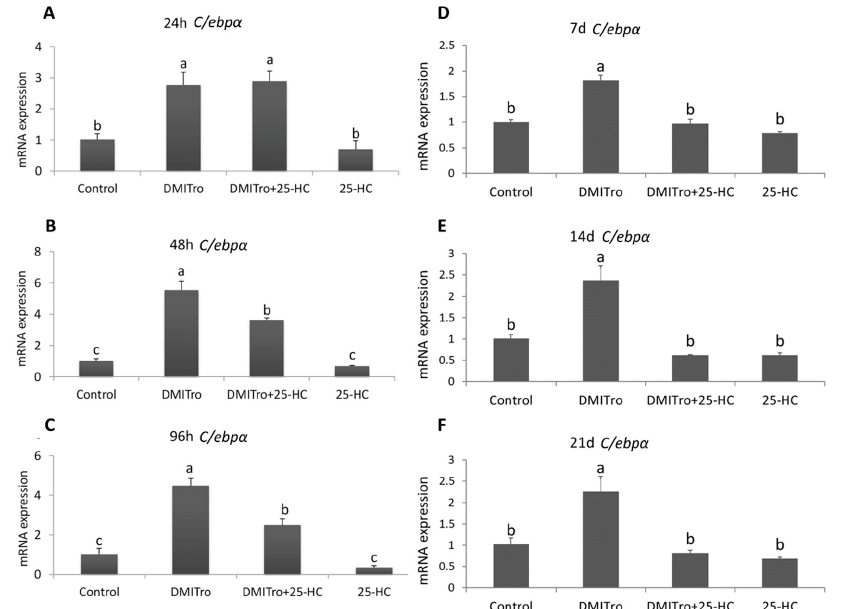
Figure 4. The effects of 25-HC on the expression of C/ebp α mRNA at different time points: ( A ) 24 hours, ( B ) 48 hours, ( C ) 96 hours, ( D ) 7 days, ( E ) 14 days, ( F ) 21 days. C3H10T1/2 cells at confluence were treated with a control, DMITro (500 nM DEX, 0.5 mM IBMX, 20 µg/mL Insulin and 10 µM Tro), DMITro + 10 µM 25-HC or 25-HC alone for 24 h, 48 h, 96 h, 7 days (d), 14 days and 21 days. The results show the average values of three replicates ( n = 3) and the SD of the means. Bars with the same letter are not significantly different.